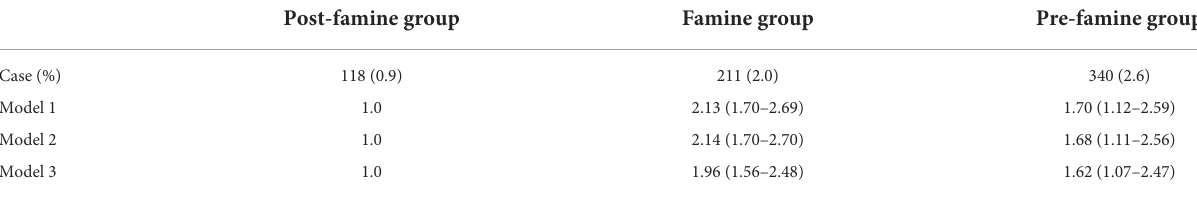
TABLE 3 Odds ratio with 95% CI of hospitalization for heart failure according to famine exposure among 36,212 participants.